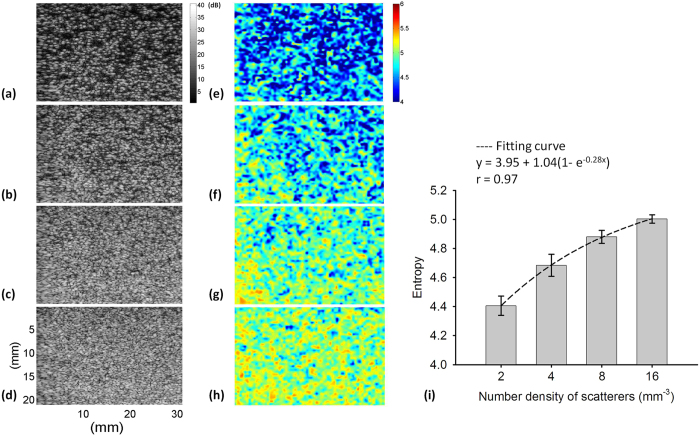
(a–d) B-mode images of Type-A agar phantoms with number densities of scatterers of 2, 4, 8, and 16 scatterers/mm3 (SL = 1; frequency = 6 MHz; scanned at a focus of 1 cm). The dimensions for all images are the same. The grayscale and color bars represent the pixel values (the brightness) of the B-mode and entropy images, respectively. (e–h) Entropy images corresponding to (a–d). (i) Entropy as a function of the number density of scatterers. Data were expressed by mean ± standard deviation.